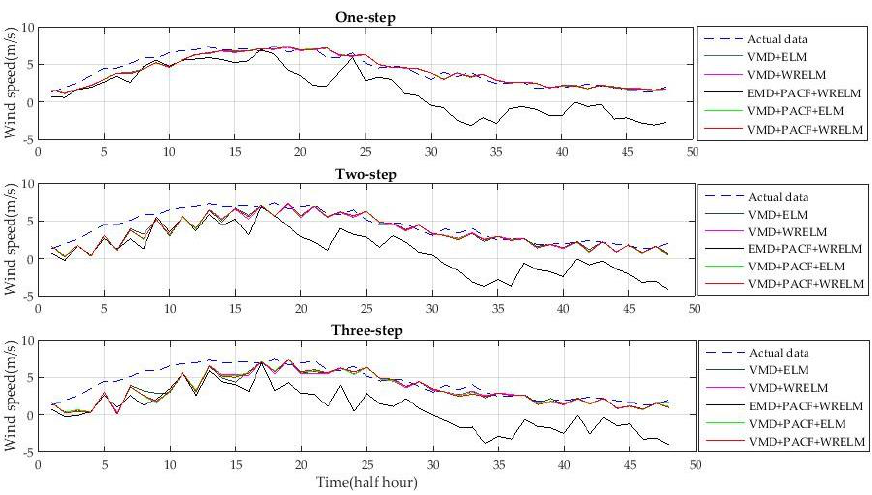
Figure 11. Forecasting results on 20 February 2004, using different methods.